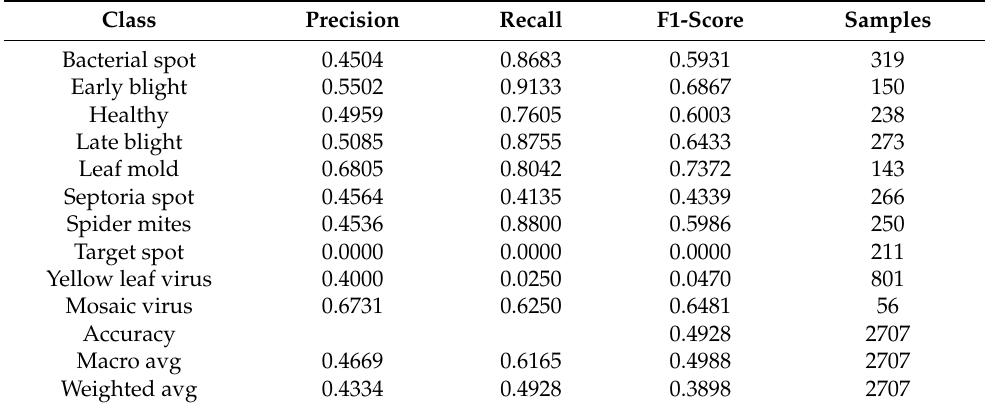
Figure 4. Confusion matrix results for the leaves’ silhouette classification with the ResNet50 model. Numbers in the matrix mean the samples classified in each class, and the colors help to identify where more samples are classified (darker colors). Table 1. Training results of the ResNet-50 model with the silhouettes